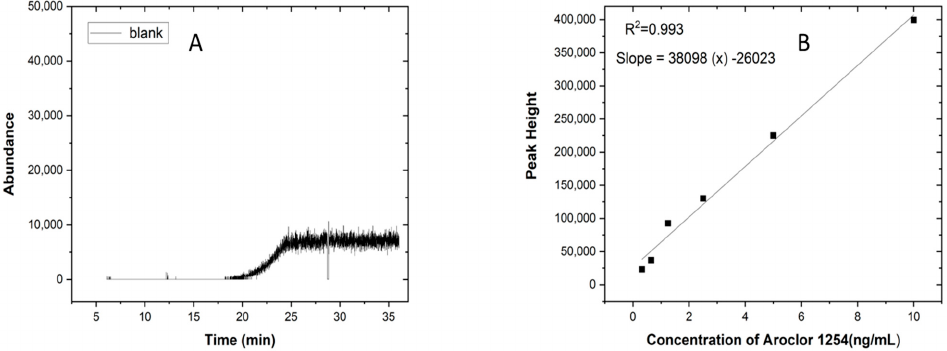
Figure 4. ( A ) GC analysis for the blank sample. ( B ) GC-MS calibration curve for standard Aroclor